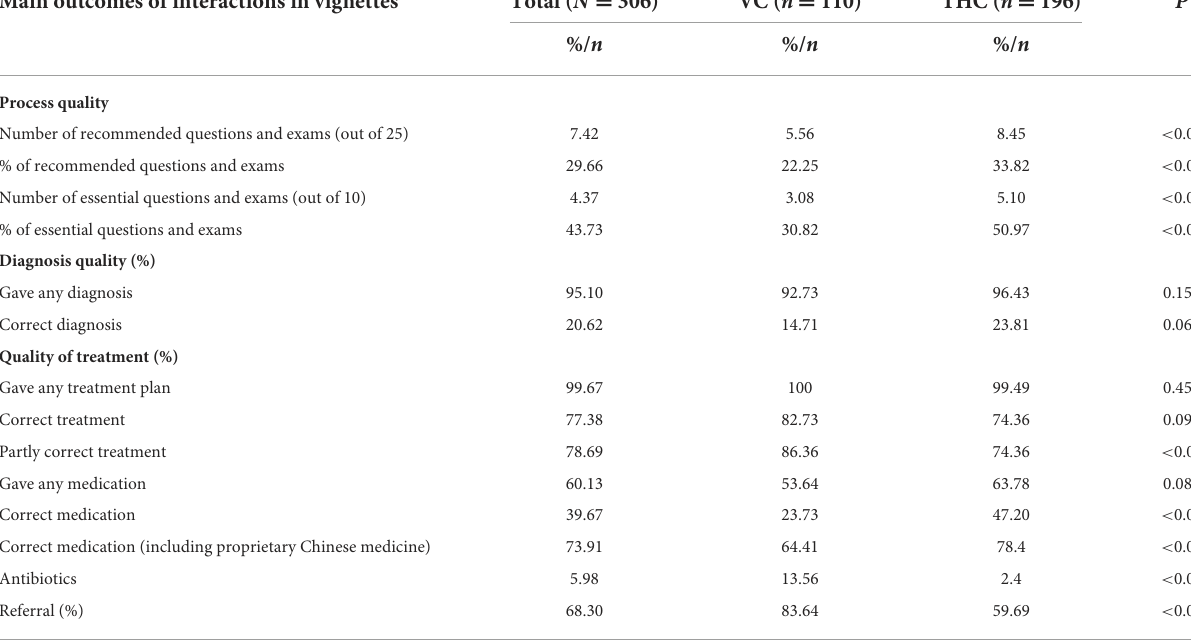
TABLE 3 Main outcomes of interactions in clinical vignettes for angina cases. Main outcomes of interactions in